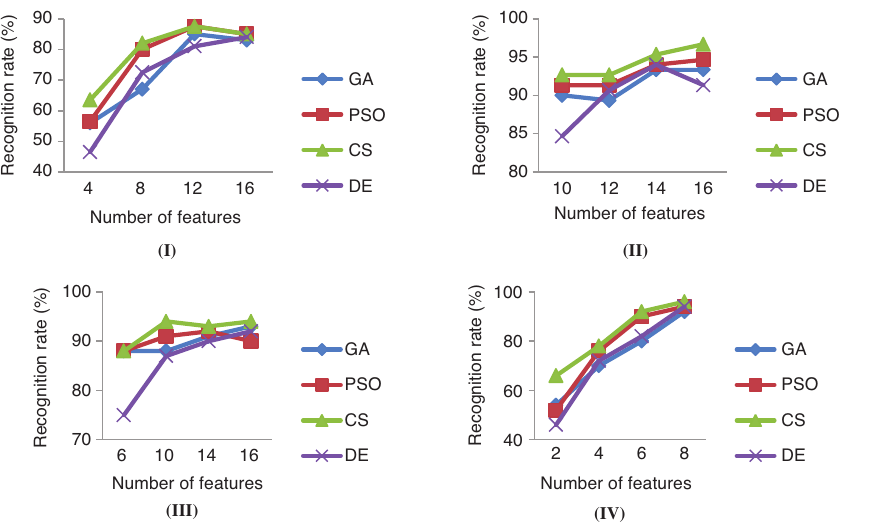
Figure 5: Effect of Noise on the Recognition Rate of Different Algorithms for ORL Case 1: (I) 40 Classes, (II) 30 Classes, (III) 20 Classes, and( IV) 10 Classes.